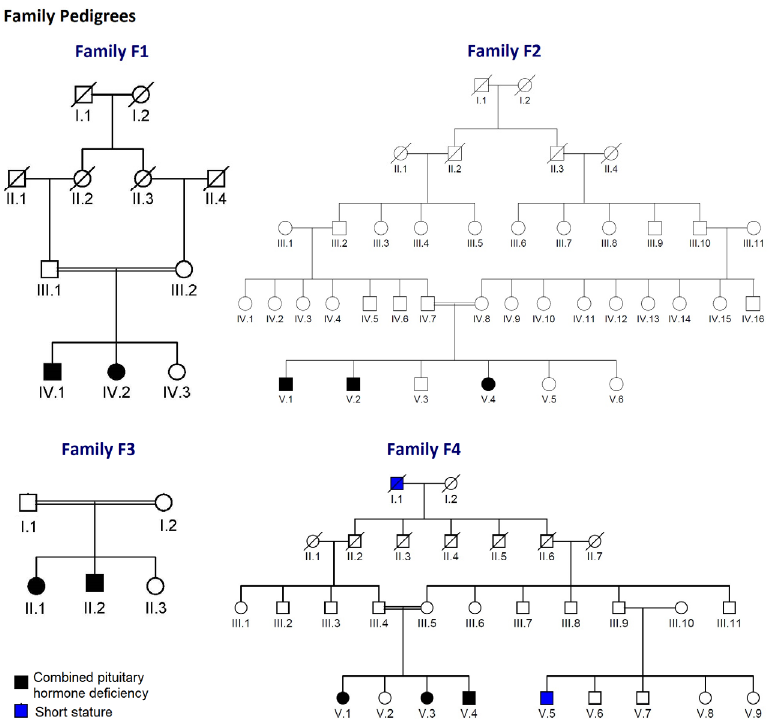
Figure 1. Pedigree of the studied families. The generations within the family are indicated by roman numerals. Squares and circles represent male and female, respectively. Normal individuals are shown as clear symbol, whereas the affected individuals are shown as filled symbol. Patients F3-II.2, F4-V.1 and F4-V.3 consult in private clinics and refuse hormonal assessment and genetic